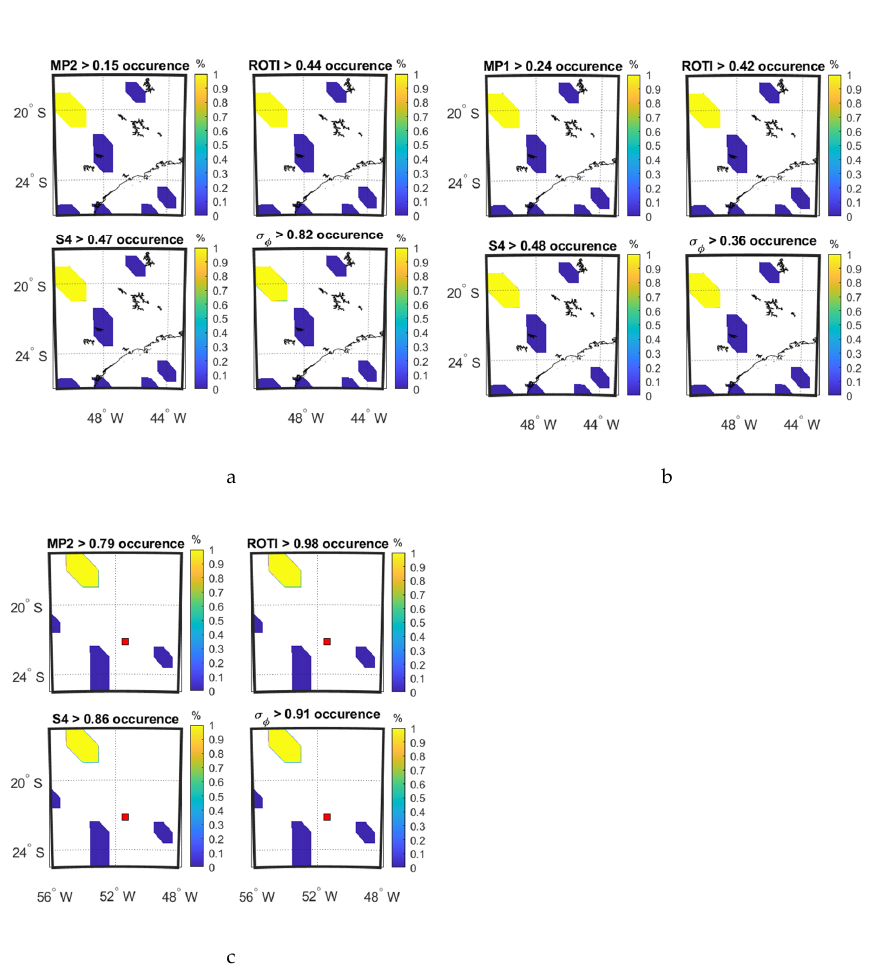
Figure 8. Occurrence percentage maps of four parameters: ( a ) during 02:59:00–03:04:00 UTC on Figure 8. xxxxxxxxx